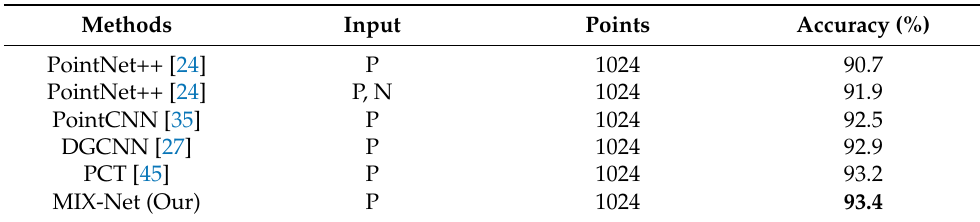
Table 6. Comparison with state-of-the-art methods on the ModelNet40 classification datasets. Preci- sion implies overall accuracy. All cited results are taken from the cited papers. P denotes the number of points, and N denotes the normal.